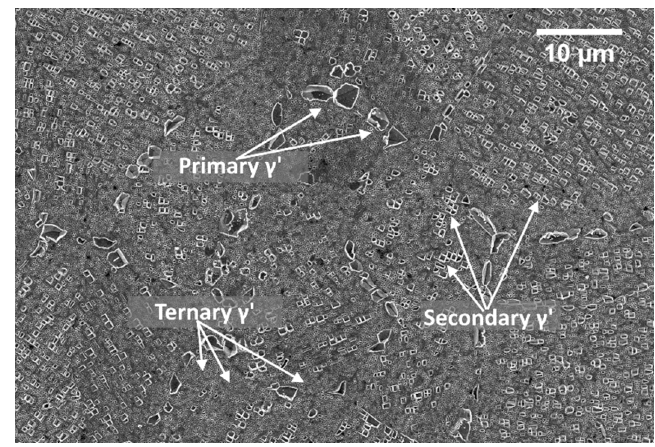
Figure 2. Generic micrograph showing the three γ ’ categories, i.e., primary, secondary and ternary.